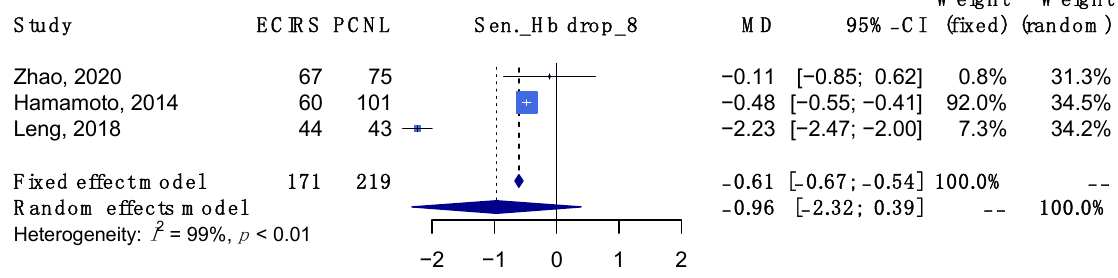
Figure A33. Sensitivity analysis of outcome regarding hemoglobin drop. ([18,19,22]).